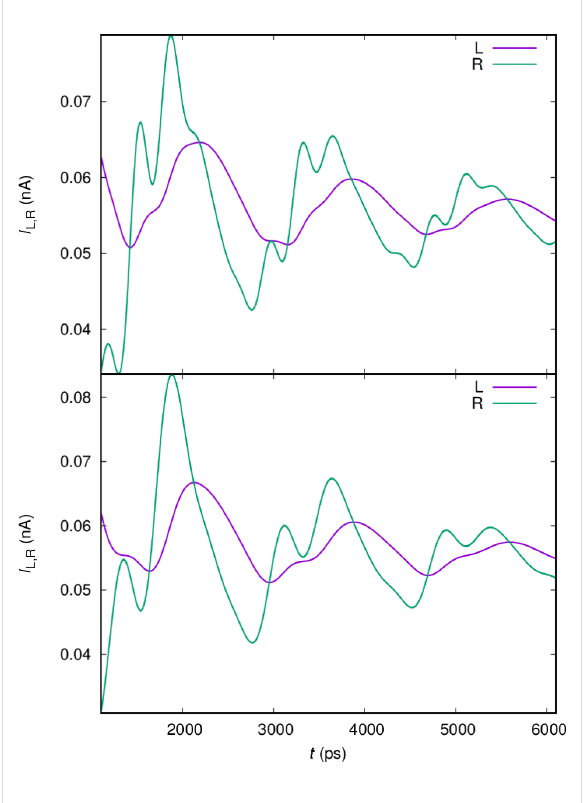
Figure 5: The current from the left lead (L) into the central system and the current from the central system into the right lead (R), for x - (upper), and y -polarized (lower) cavity photon field. g EM = 0.05 meV, = 0.343 meV, κ = 1.0 × 10 − 5 meV, = 0, and B ext = 0.1